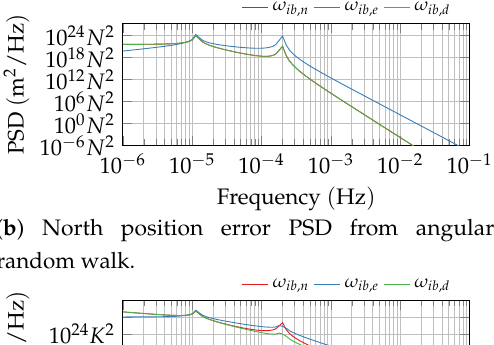
( a ) North position error PSD from velocity random walk.